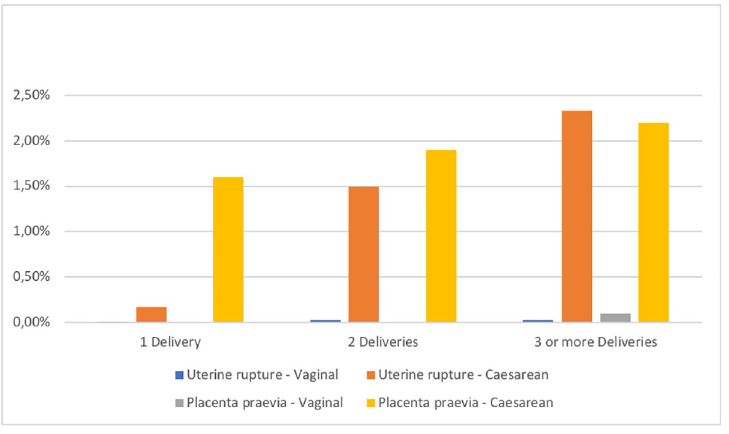
Fig 2. Risk in per cent for uterine rupture and placenta praevia after 1, 2 or 3 or more deliveries.